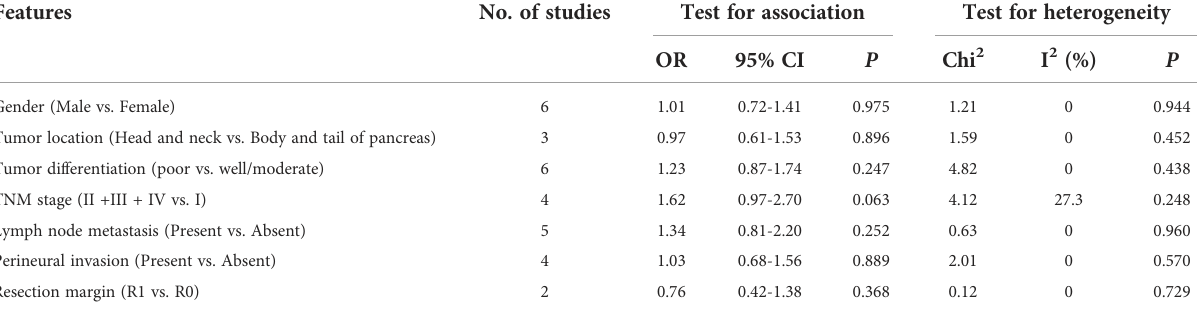
TABLE 3 The relationship between PKM2 and clinicopathologic characteristics.